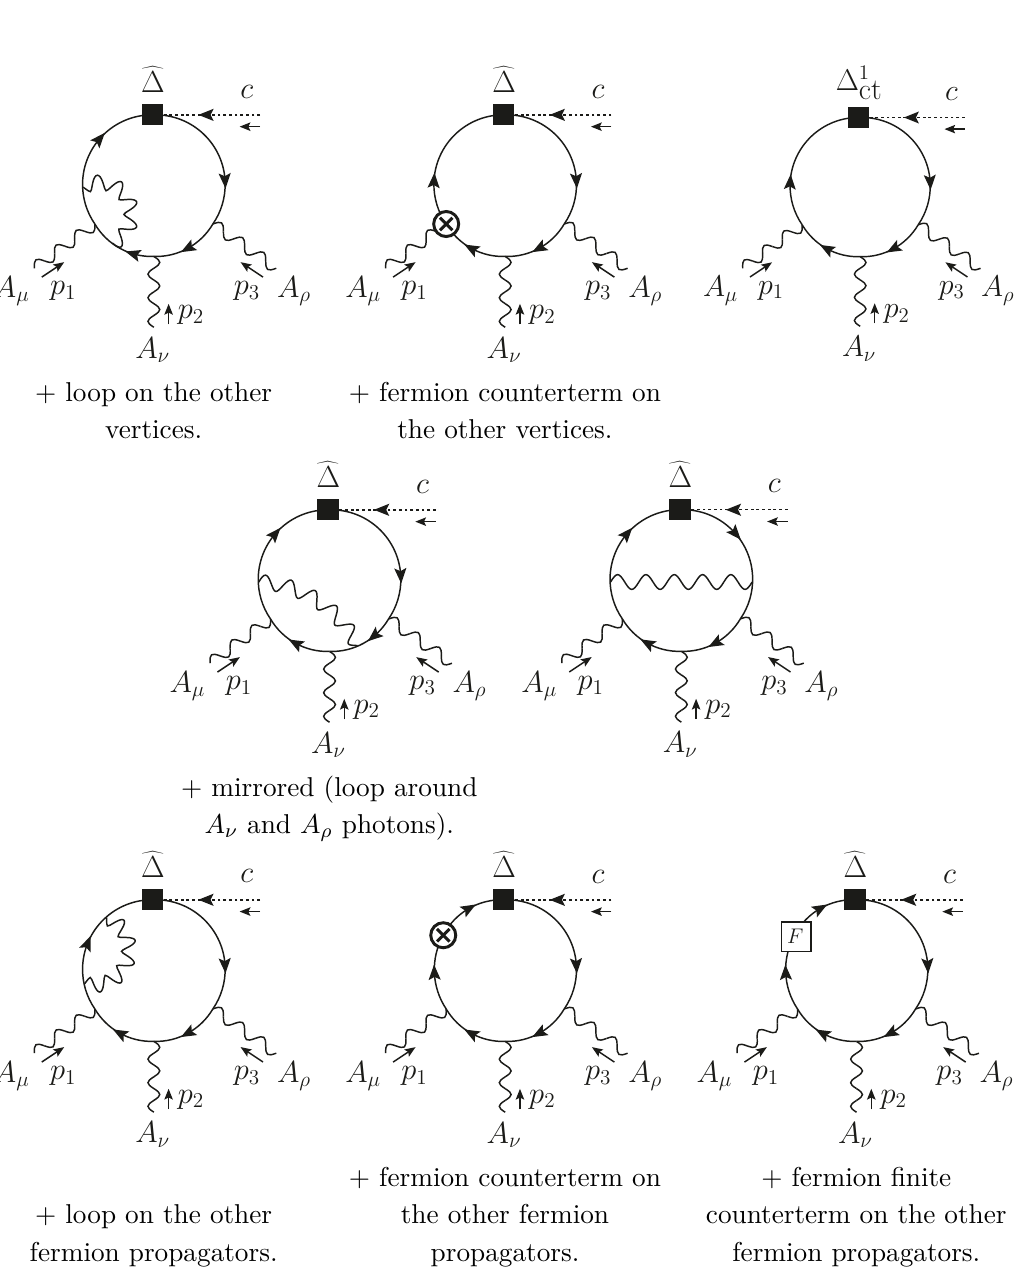
Figure 4 . List of Feynman diagrams for the Ghost-three gauge bosons breaking contribution (additional diagrams corresponding to { ( p 1 , µ ) , ( p 2 , ν ) , ( p 3 , ρ ) } permutations are not shown). The symbols are as in figure 2 and the results are given in eq.